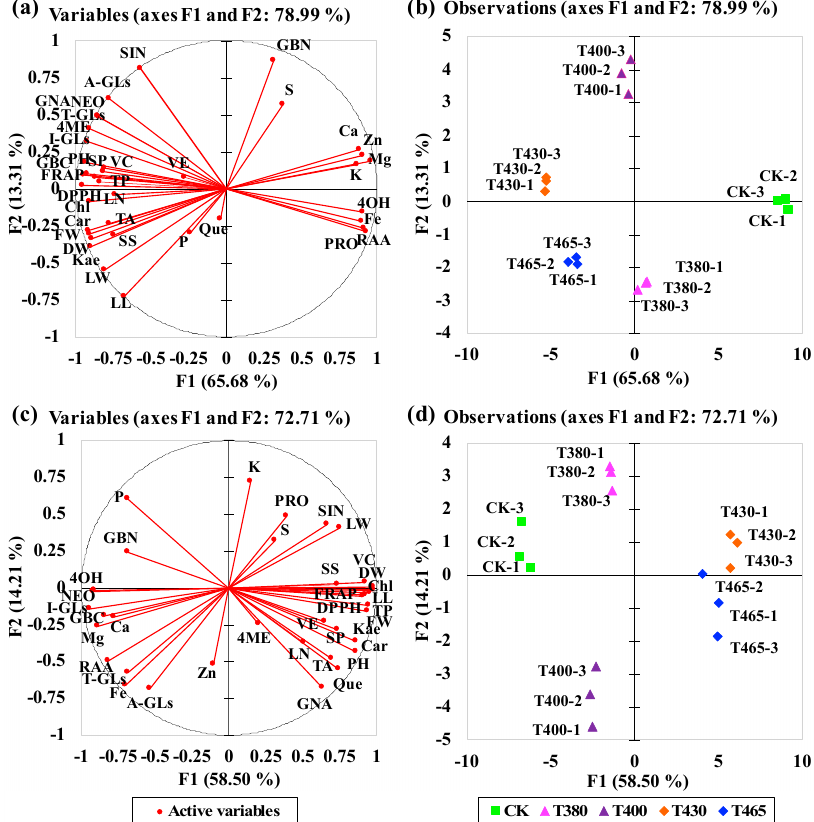
Figure 6. Multivariate principal component analysis showing the effects of supplementary blue and UV-A wavebands on two baby-leaves. The correlation circle of ( a ) Chinese kale and ( c ) Pak-choi. The scatter plot of ( b ) Chinese kale and ( d ) Pak-choi. FW = fresh weight, DW = dry weight, PH = plant height, LL = leaf length, LW = leaf width, LN = leaf number, Chl = chlorophylls, Car = carotenoids, TA = anthocyanins, VC = vitamin C, VE = vitamin E, TP = phenolics, Kae = kaempferol, Que = quercetin, DPPH = 2,2-diphenyl-1-picrylhydrazyl radical scavenging, FRAP = ferric reducing antioxidant power, SP = soluble proteins, SS = soluble sugars, A-GLs = aliphatic flucosinolates, I-GLs = indolic glucosinolates, T-GLs = total glucosinolates, PRO = progoitrin, RAA = glucoraphanin, SIN = sinigrin, GNA = gluconapin, GBN= glucobrassicanapin, 4OH = 4-hydroxyglucobrassicin, GBC = glucobrassicin, 4ME = 4-methoxyglucobrassicin, NEO = neoglucobrassicin, P = phosphorous, K = potassium, Ca = calcium, Mg = magnesium, S = sulphur, Zn = zinc, Fe = iron.